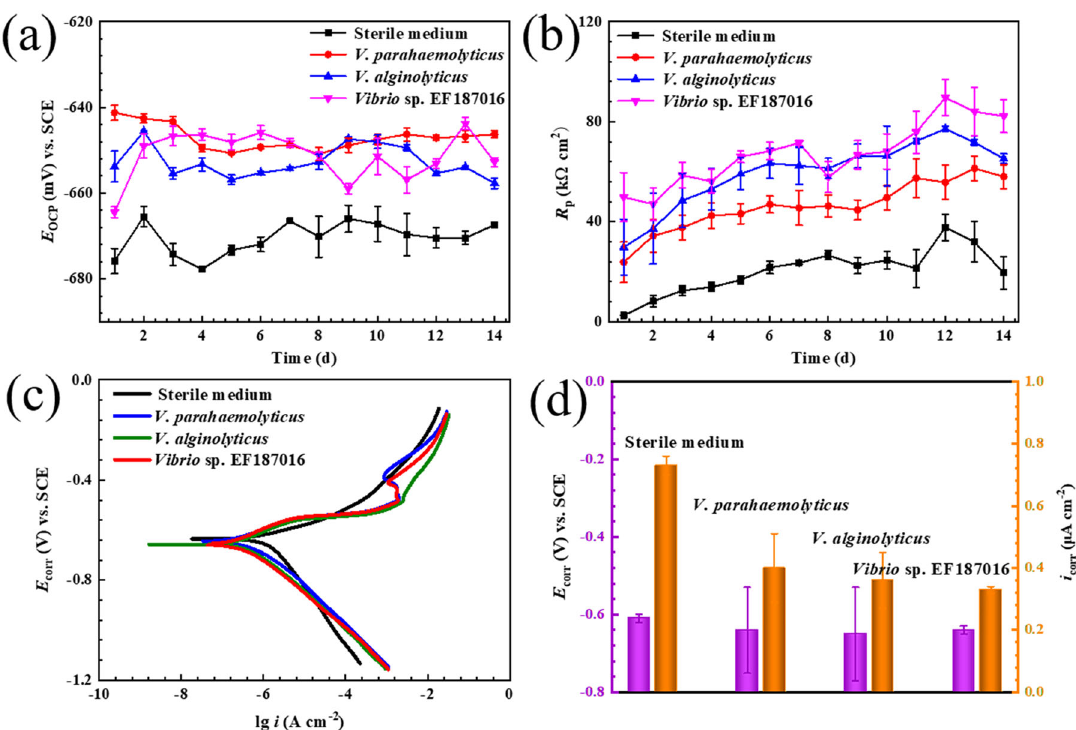
Fig. 4 Electrochemical measurements of X80 coupons. a E OCP in different media during 14-d incubation, b R P in different media during 14-d incubation, c potentiodynamic polarization curves at the end of the 14-d immersion, and d Ecorr and icorr from Tafel analysis of panel ( c ).